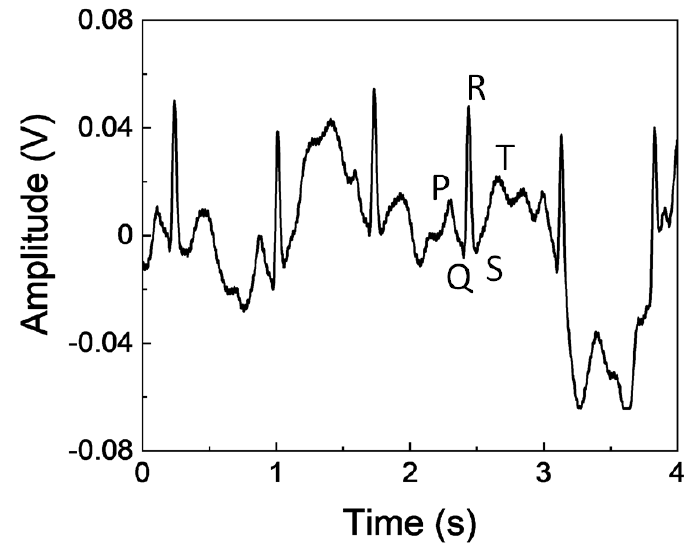
Figure 8. ECG signal acquired while the subject is